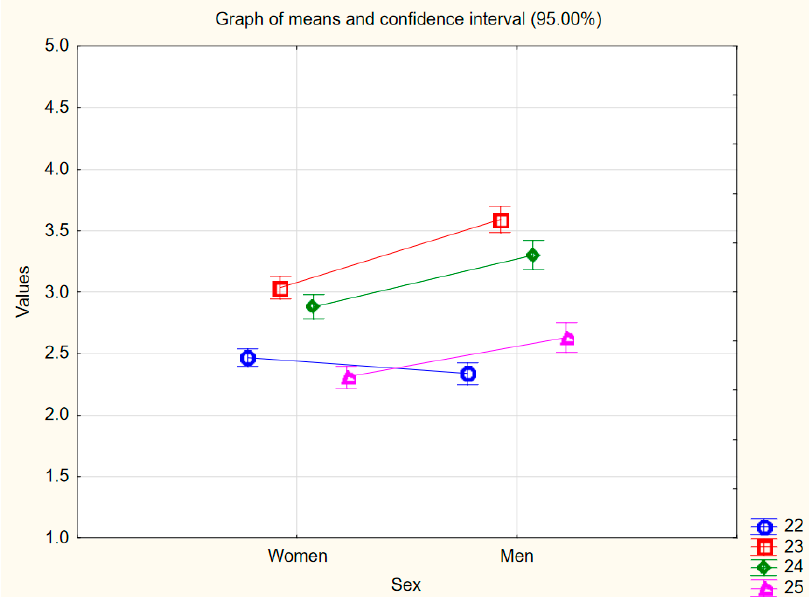
Figure 5. Categorized mean values of the semantic differential regarding the characteristics of nuclear energy (own research). Theses numbers: 22—the nuclear fuel base in Poland is (1—small; 5—large); 23—the safety of nuclear power is (1—dangerous; 5—safe); 24—environmental pollution caused by nuclear power is (1—large; 5—small); 25—nuclear energy costs are (1—high; nuclear power is (1—large; 5—small); 25—nuclear energy costs are (1—high; 5—small). 5—small).